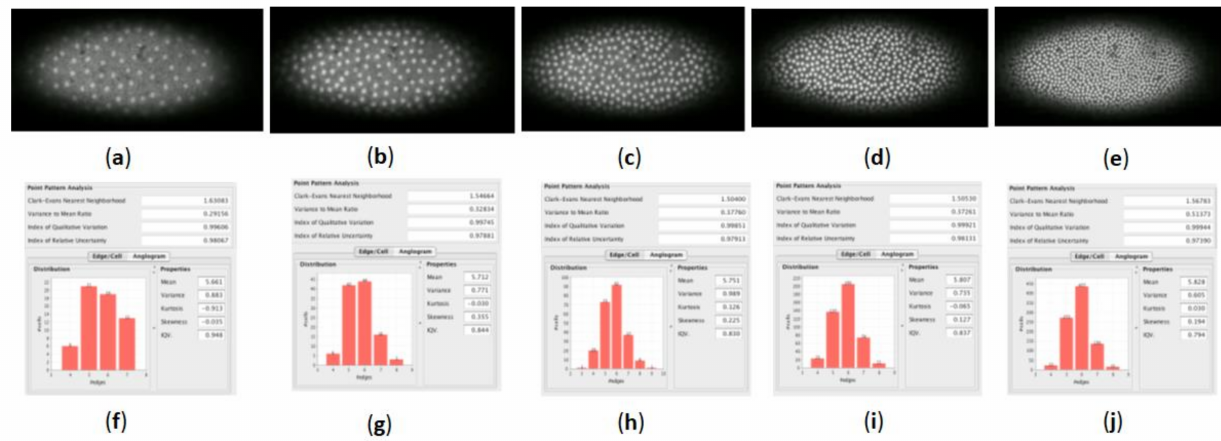
Figure 12. Five generations of successive divisions of Drosophila embryogenesis from film by Thomas Gregor [15]: ( a ) 3 s ( b ) 8 s ( c ) 14 s ( d ) 34 s ( e ) 42 s; ( f – j ) corresponding indices of dispersion and histographic frequencies of edges per polygon in the respective Voronoi tessellation for each of the five images using nuclei as Voronoi generator points in Ka-me (from Reinfleisch and Jungck